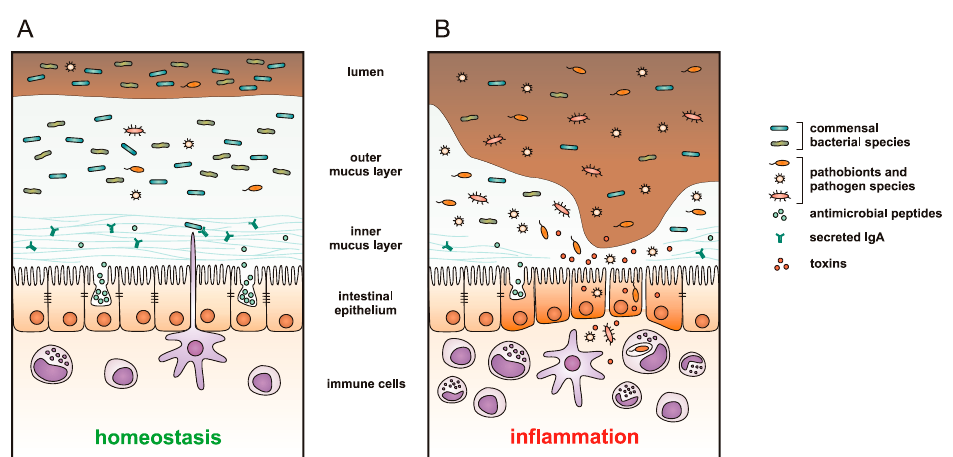
Figure 1. A schematic representation of intestinal mucosa in ( A ) healthy; and ( B ) inflammatory bowel